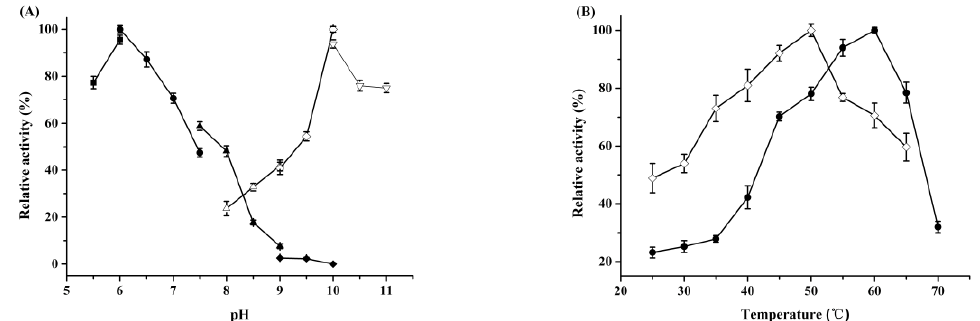
Figure 3. Effect of pH ( A ) and temperature ( B ) on the activity of recombinant ReCR. The relative activities of 100% represent 85.8 U/mg for NBPO reduction (solid symbols) and 88.3 U/mg for ( R / S )-2-octanol oxidation (open symbols). The buffers 2-( N -morpholino)ethanesulfonic acid (MES, ■ ), piperazine-1,4-bisethanesulfonic acid(PIPES, ● ), Tris-HCl ( ▲ ), and 3-(cyclohexylamino)-2-hydroxy-1-propanesulfonic acid (CAPSO, ◆ ) were used for the reduction reaction, while the buffers Tris-HCl ( △ ), CAPSO ( ◇ ), and 3-(cyclohexylamino)-1-propanesulfonic acid (CAPS, ▽ ) were used for the oxidation reaction.